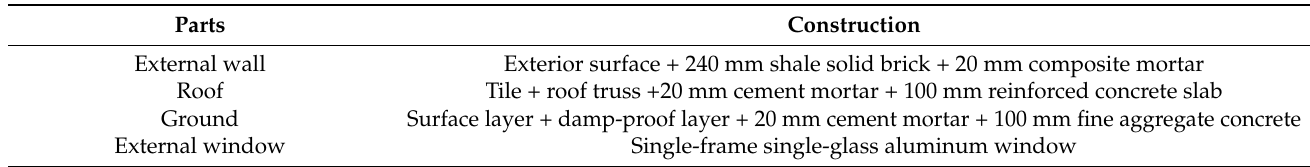
Table 1. Building envelope parameters for the benchmark